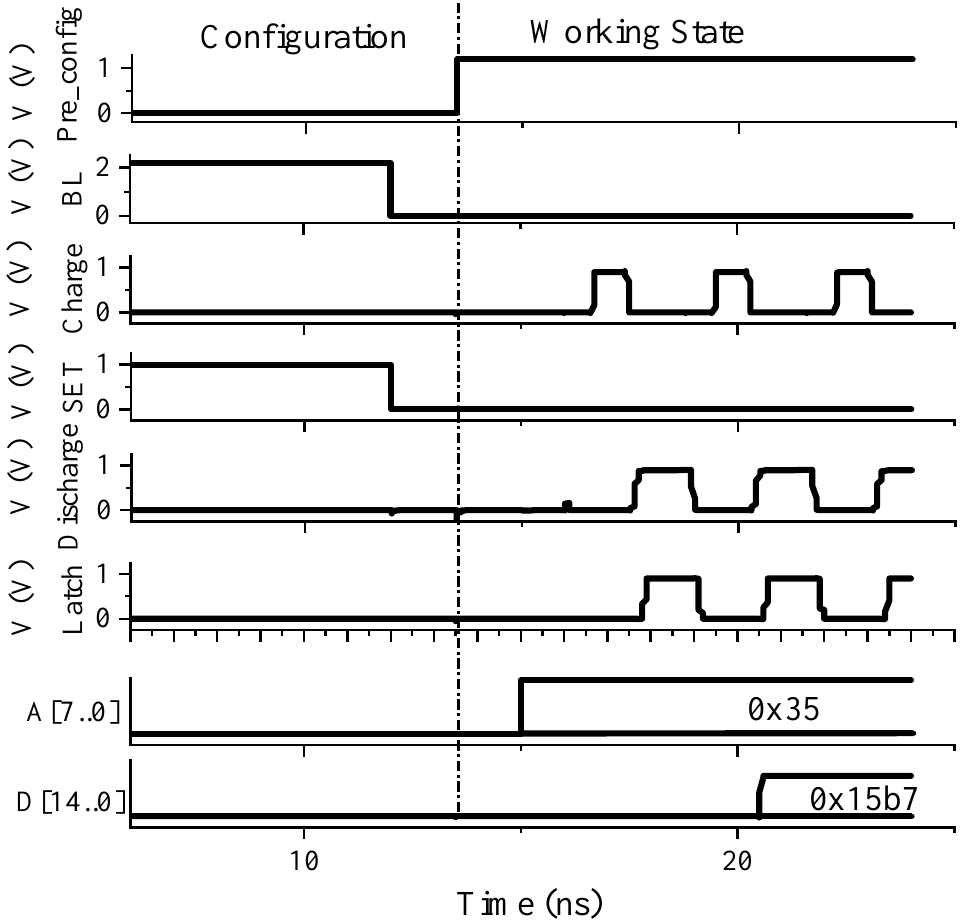
Figure 11. Transient simulation of an 8-bit radix-4 non-volatile parallel multiplier with multiplicator B =